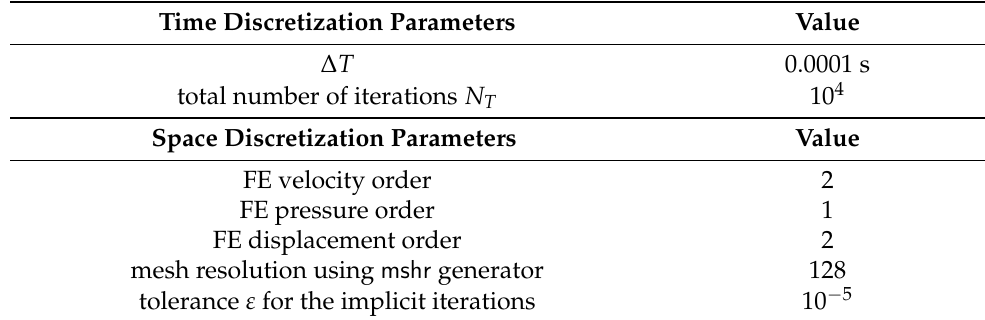
Table 3. Values of the parameters in the time discretization and in the spatial discretization.